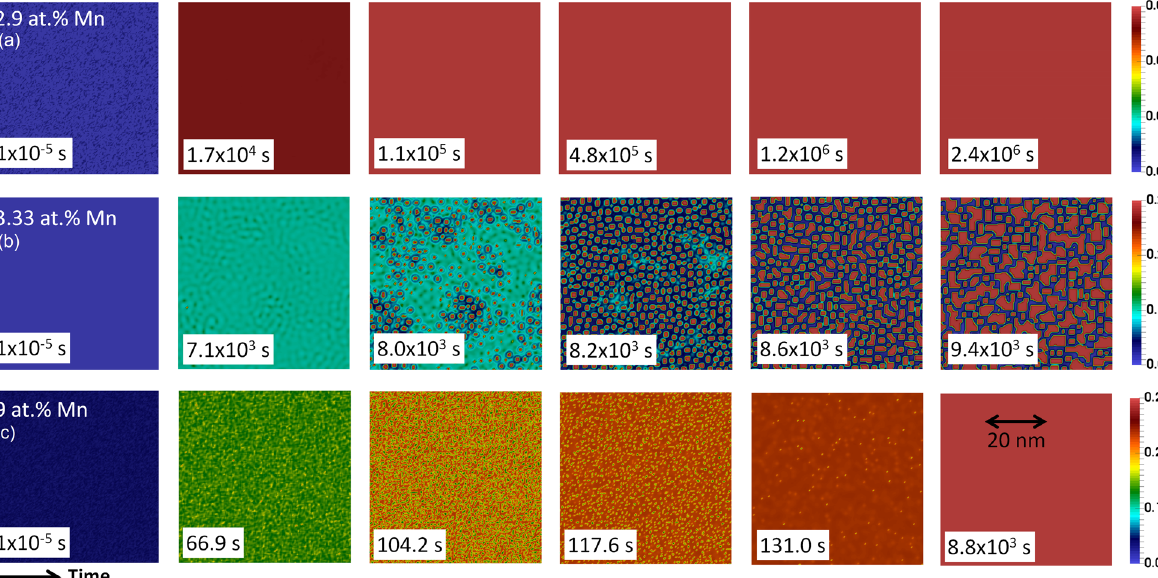
Fig. 4 Time evolution of Mn concentration in the GB plane. 2D cross sections (GB in-plane view) from 3D simulations are shown for three different alloys with a 2.9, b 3.3, and c 9 at.% Mn (450 °C). For an alloy with 3.3 at.% Mn (close to jump composition) an interfacial spinodal phase separation is observed. Above this composition, we have found a transient spinodal regime demonstrated for Fe – 9 at.% Mn